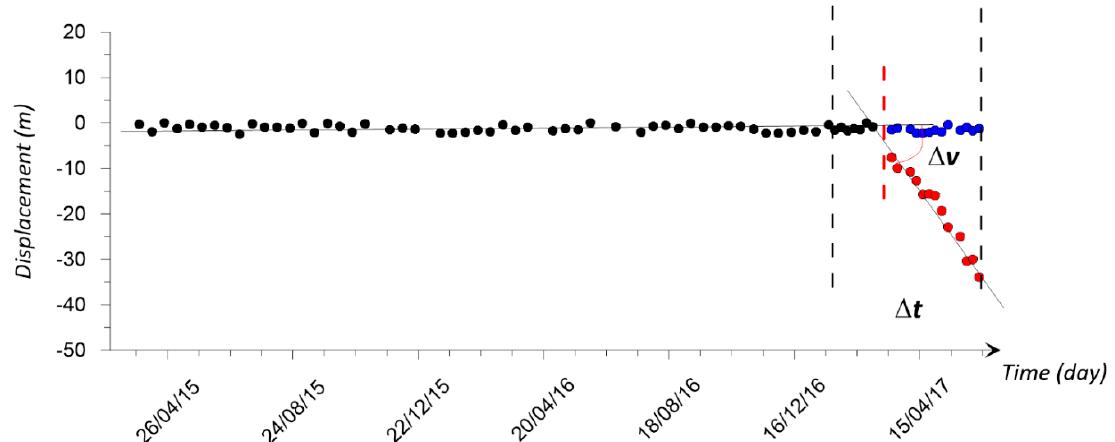
Figure 3. Schematic explanation of the automatic APs detection algorithm. Δ t is the temporal search window, Δ v is the velocity variation. The blue points represent a possible time series without variations, whereas the red points simulate an abrupt acceleration.